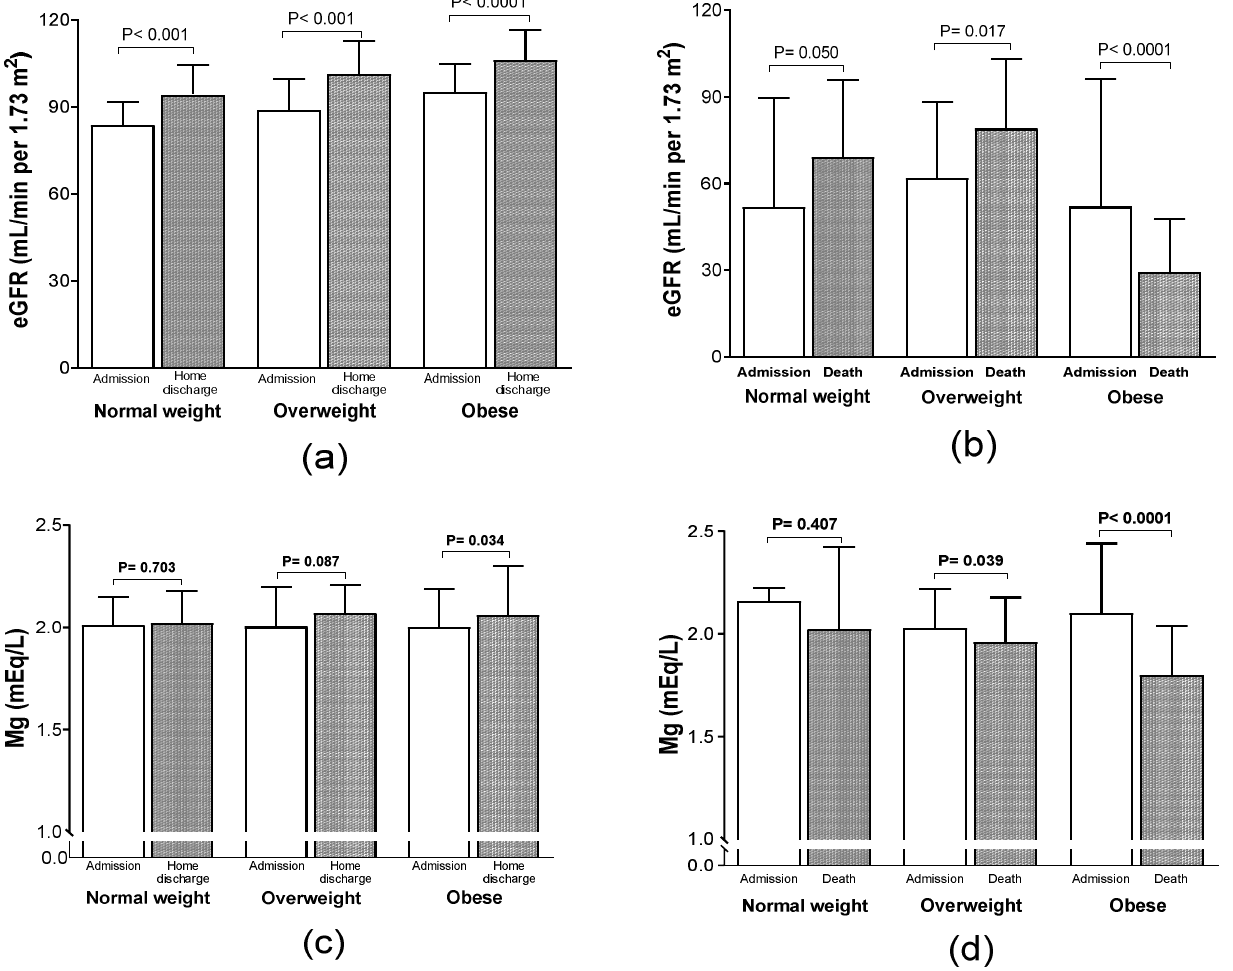
Figure 1. Renal function and magnesium levels by BMI distribution in COVID-19 patients. ( a ) renal function in home discharge patients; ( b ) Renal function in death patients; ( c ) Magnesium levels in home discharge patients; ( d ) Magnesium levels in death patients. Data are presented as median and interquartile range. The comparison between the groups were analyzed by Wilcoxon signed-rank test. p < 0.05 was considered significant.